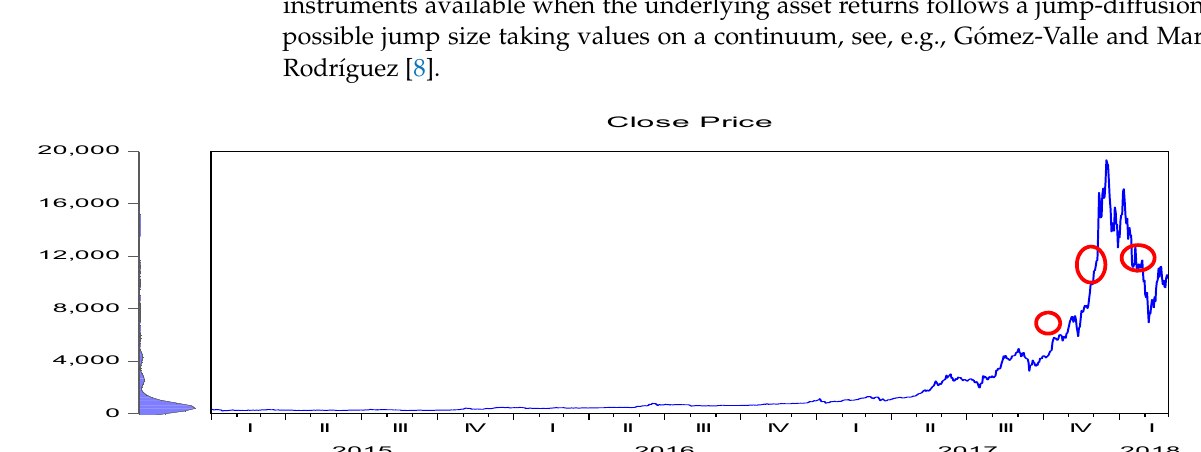
Figure 1. Market Price of Bitcoin in the Bitcoin/USD exchange rate from 1 January 2015 to 28 February 2018. Notes. Jump effect of Bitcoin price revaluation on Bitcoin/USD exchange rate, huge jump starting from Q3/2017.